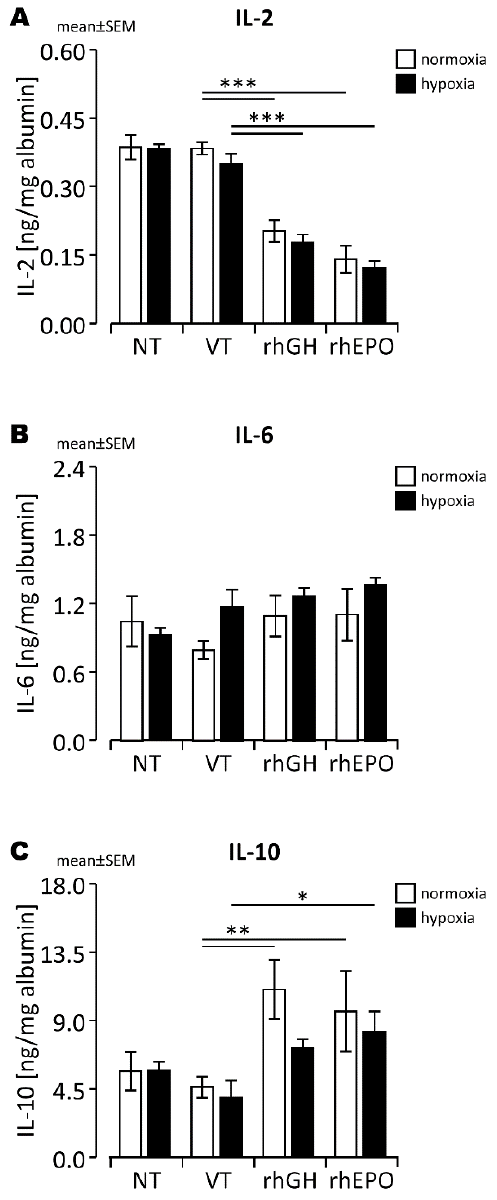
Figure 6. Protein levels of ( A ) IL-2, ( B ) IL-6, and ( C ) IL-10 in normoxic and hypoxic mouse brains after a 48 h regeneration period. *, p < 0.05; **, p < 0.01; ***, p < 0.001.